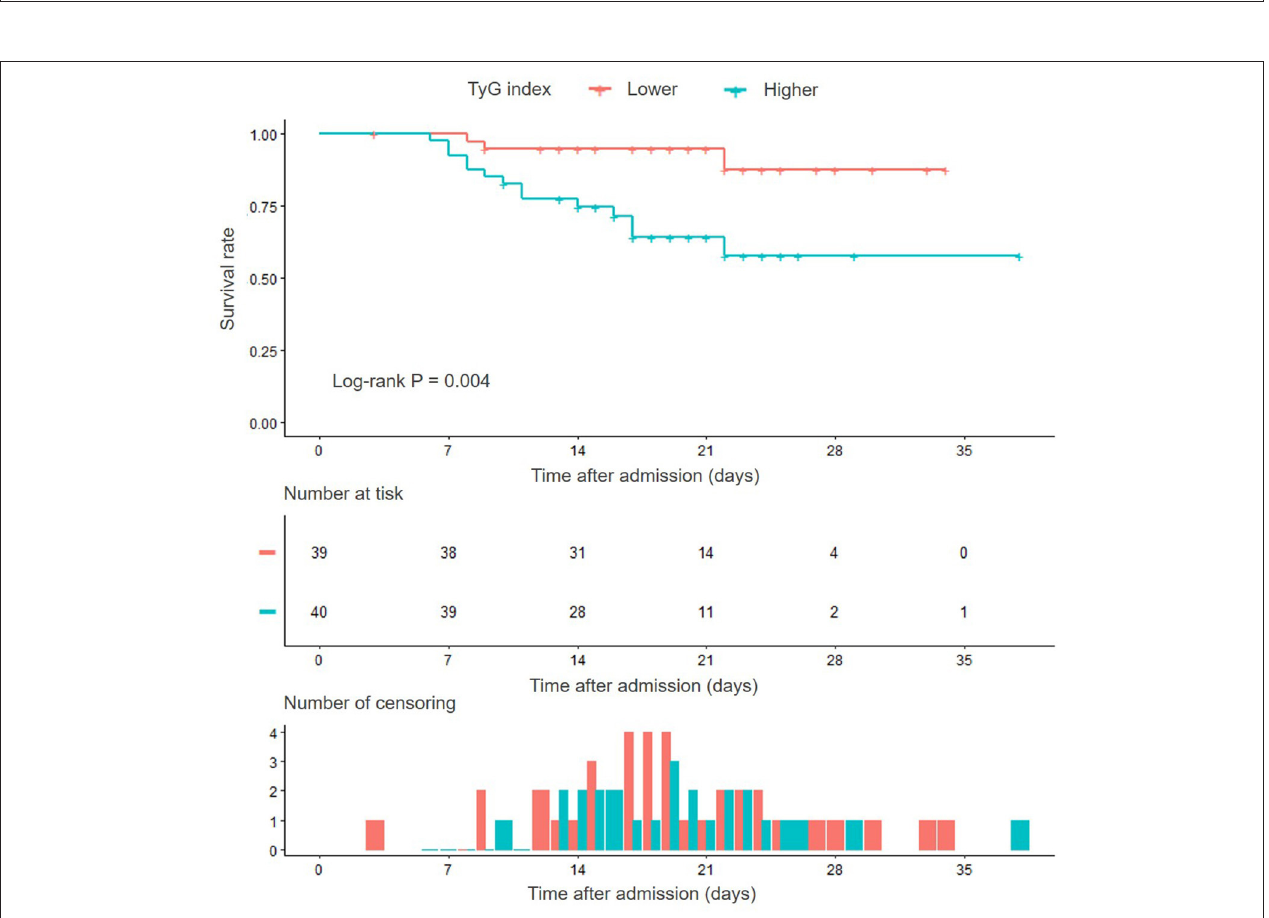
Frontiers in Medicine |